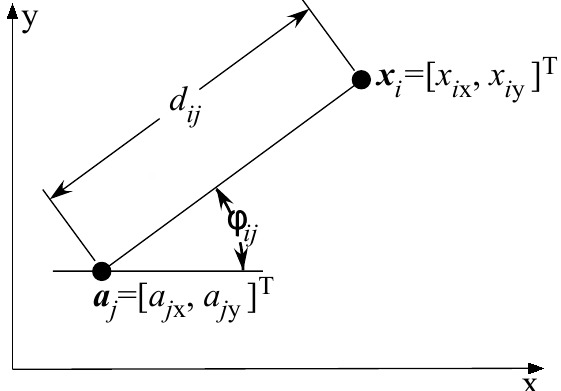
Figure 4. Illustration of the considered model in 2-dimensional